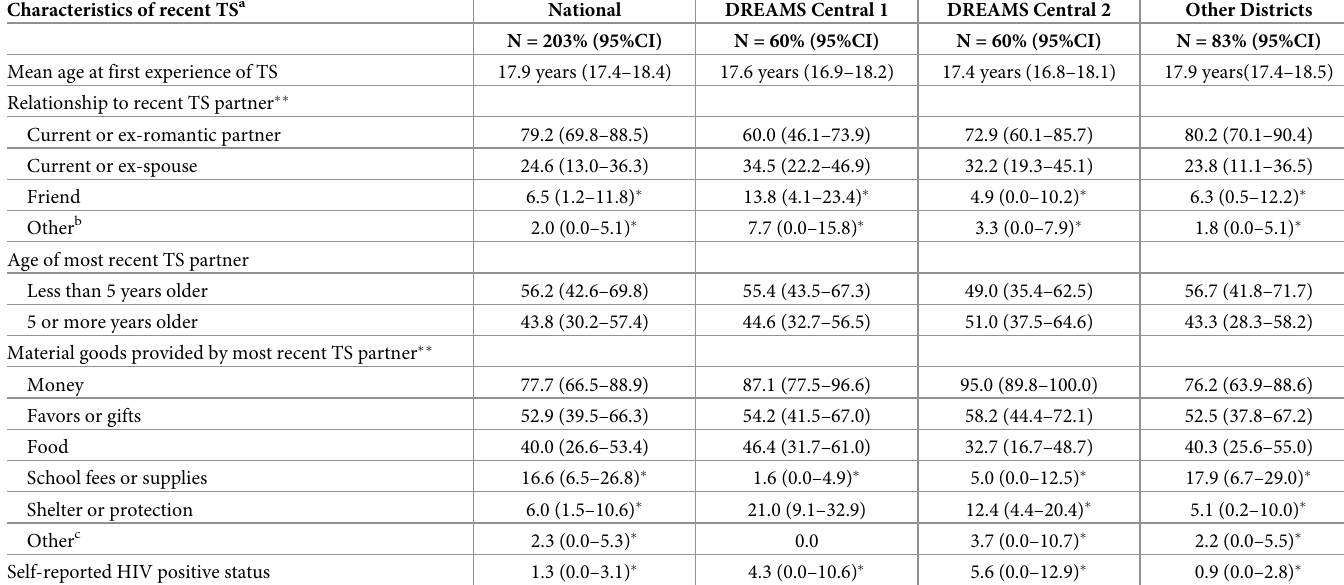
Table 3. Characterization of recent transactional sex, among Ugandan adolescent girls and young women who engaged in recent transactional sex, ages 13–24 years old. Characteristics of recent TS